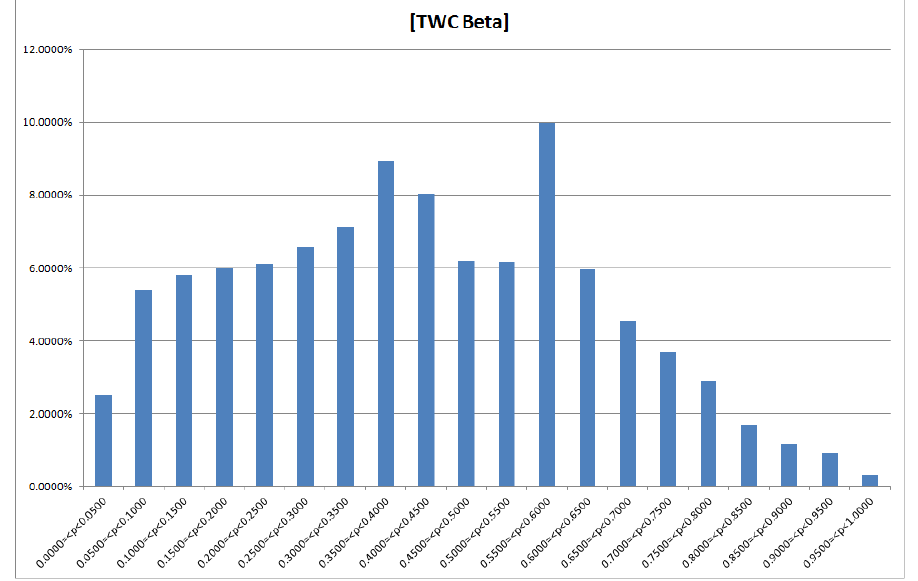
Figure 14. Probability of the epidemics in TWC- β map, in relation to the global areas of the map (20